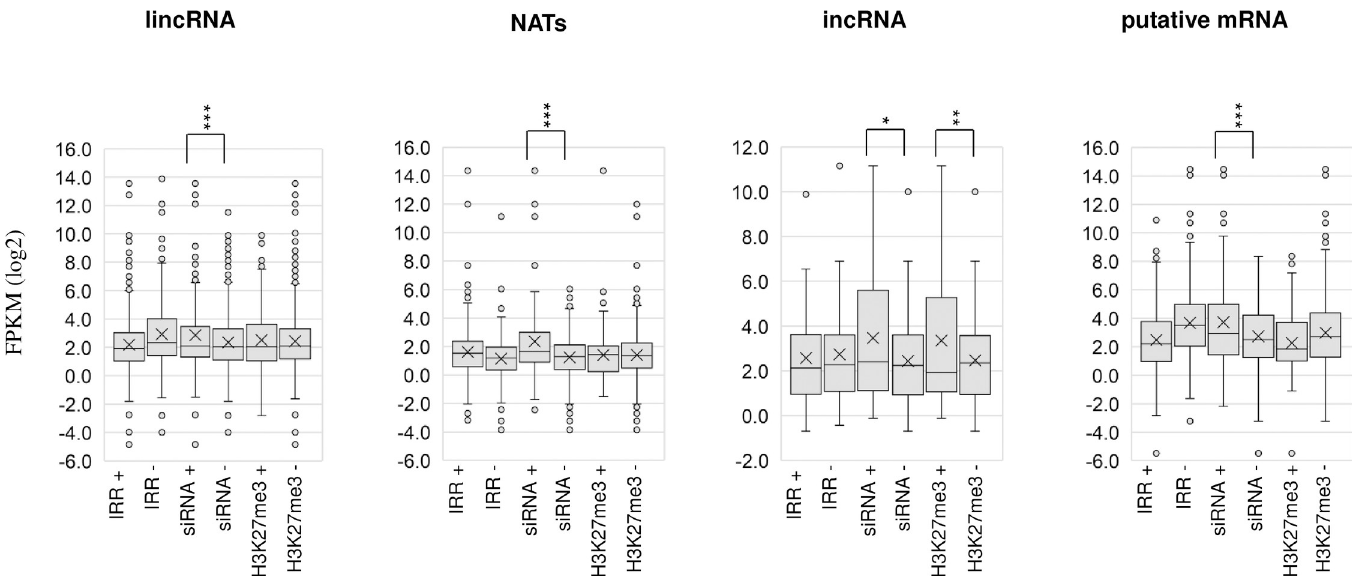
Fig 5. Expression level of each type of RNAs with (+) or without (-) overlapping IRRs, 24nt-siRNAs, or H3K27me3. � , p < 0.05; �� , p < 0.01; ��� , p < 0.001 (Student t- test).